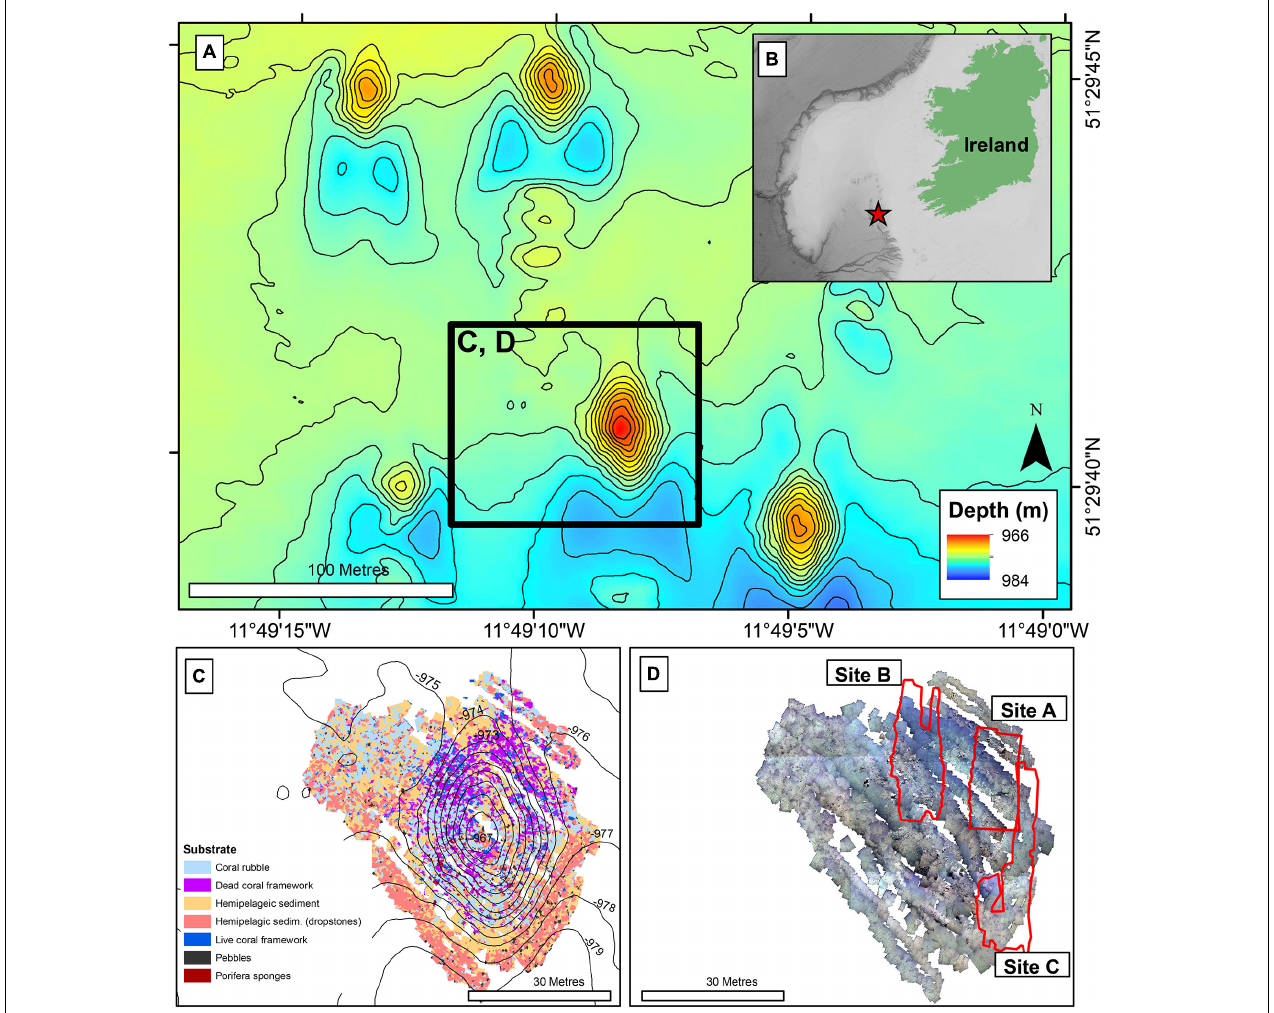
FIGURE 1 | Location map: (A) Bathymetry (contour interval 1 m) of Moira Mound region showing Piddington Mound (within black square). Black square represents panel (C,D) ; (B) Regional map. Red star indicates the Location of Moira Mound region. (C) Substrate map, contour interval: 1 m (data from Conti et al., 2019); (D) Photomosaic of Piddington Mound (data from Lim et al., 2017), with Site A, B, and C showing the areas of interests for the current